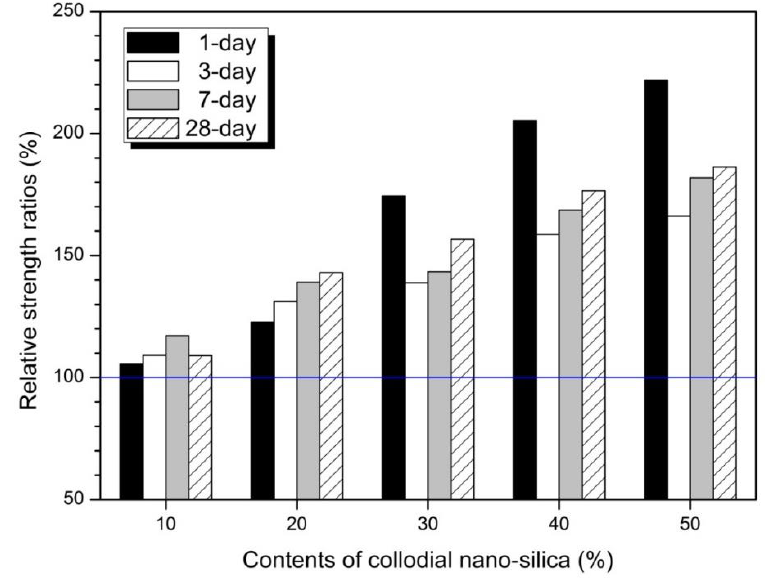
Figure 4. Compression strength increase rate according to the CNS replacement ratio.